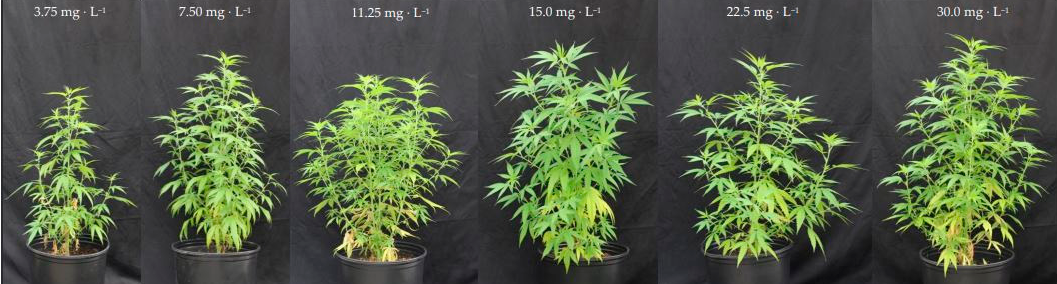
Figure 2. Eight-week-old vegetative plants across all P fertility concentrations. Note the decrease in branching and height at the lowest fertility treatments (3.75 and 7.50 mg·L − 1).